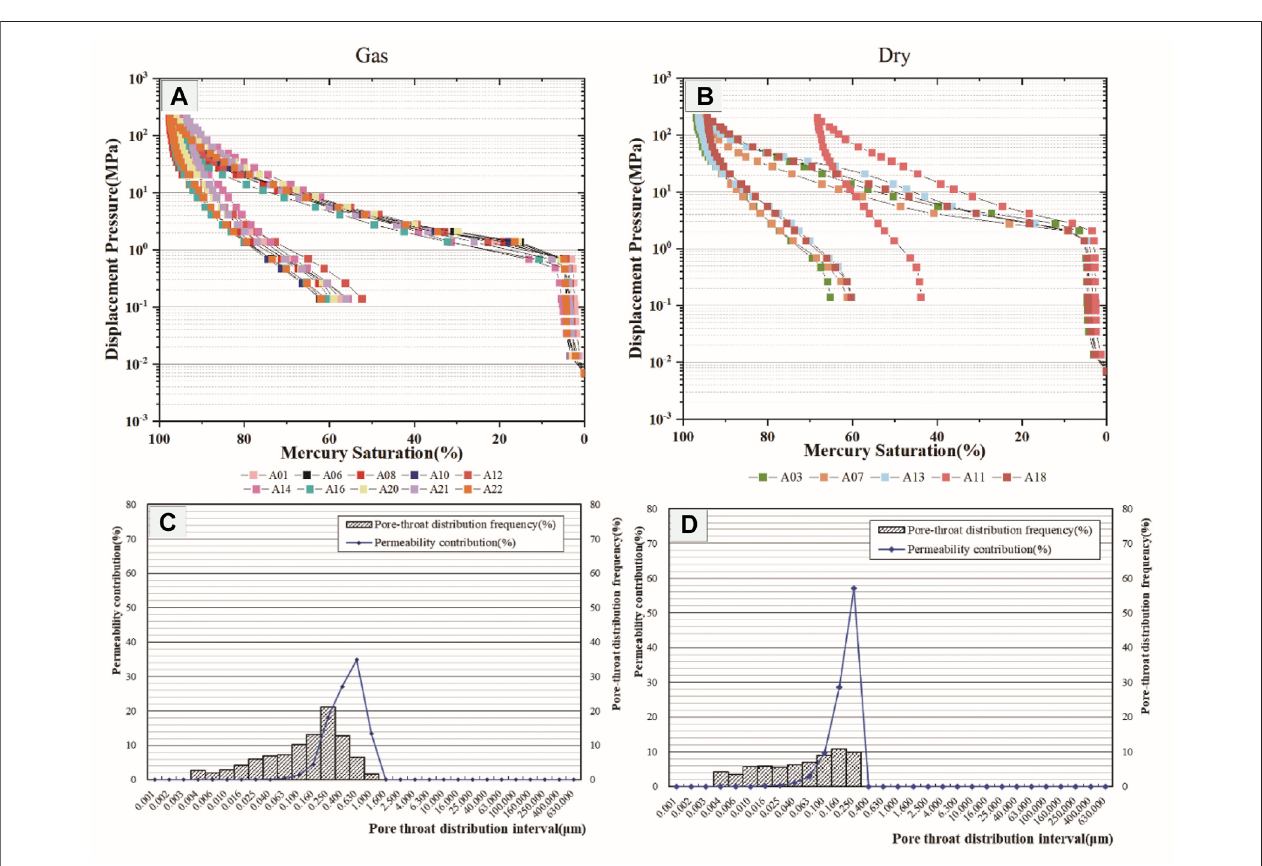
FIGURE 6 | Typical HPMI curves of samples from gas-bearing (A) and dry (B) formations; and the typical PSDs obtained from HPMI experiments for gas-bearing [ (C) , sample A4] and dry [ (D) , sample A11] formations.